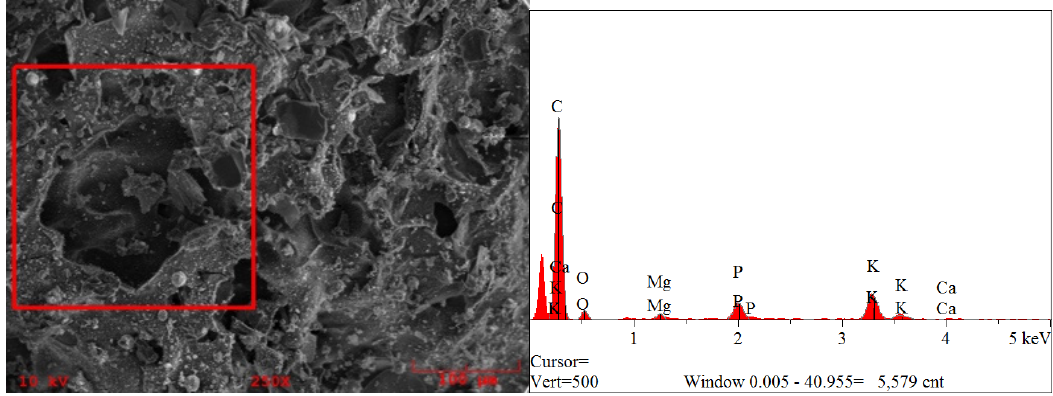
Figure 4. Surface area analysis from corn biochar - pore region (Elements from left to right K, Ca, C, Mg, P, K, Ca).